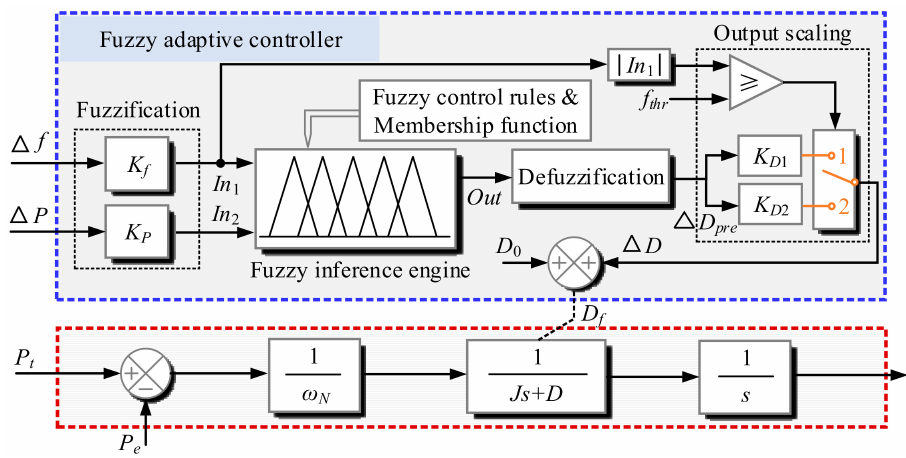
Figure 8. Block diagram of the proposed fuzzy adaptive damping control based